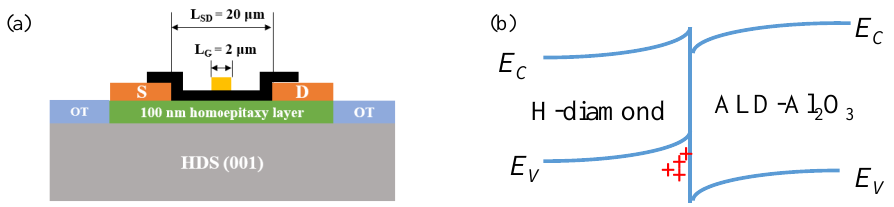
Figure 2. ( a ) Schematic diagram of the MOSFET; ( b ) energy band diagram of H-diamond/Al 2 O 3 without gate bias.